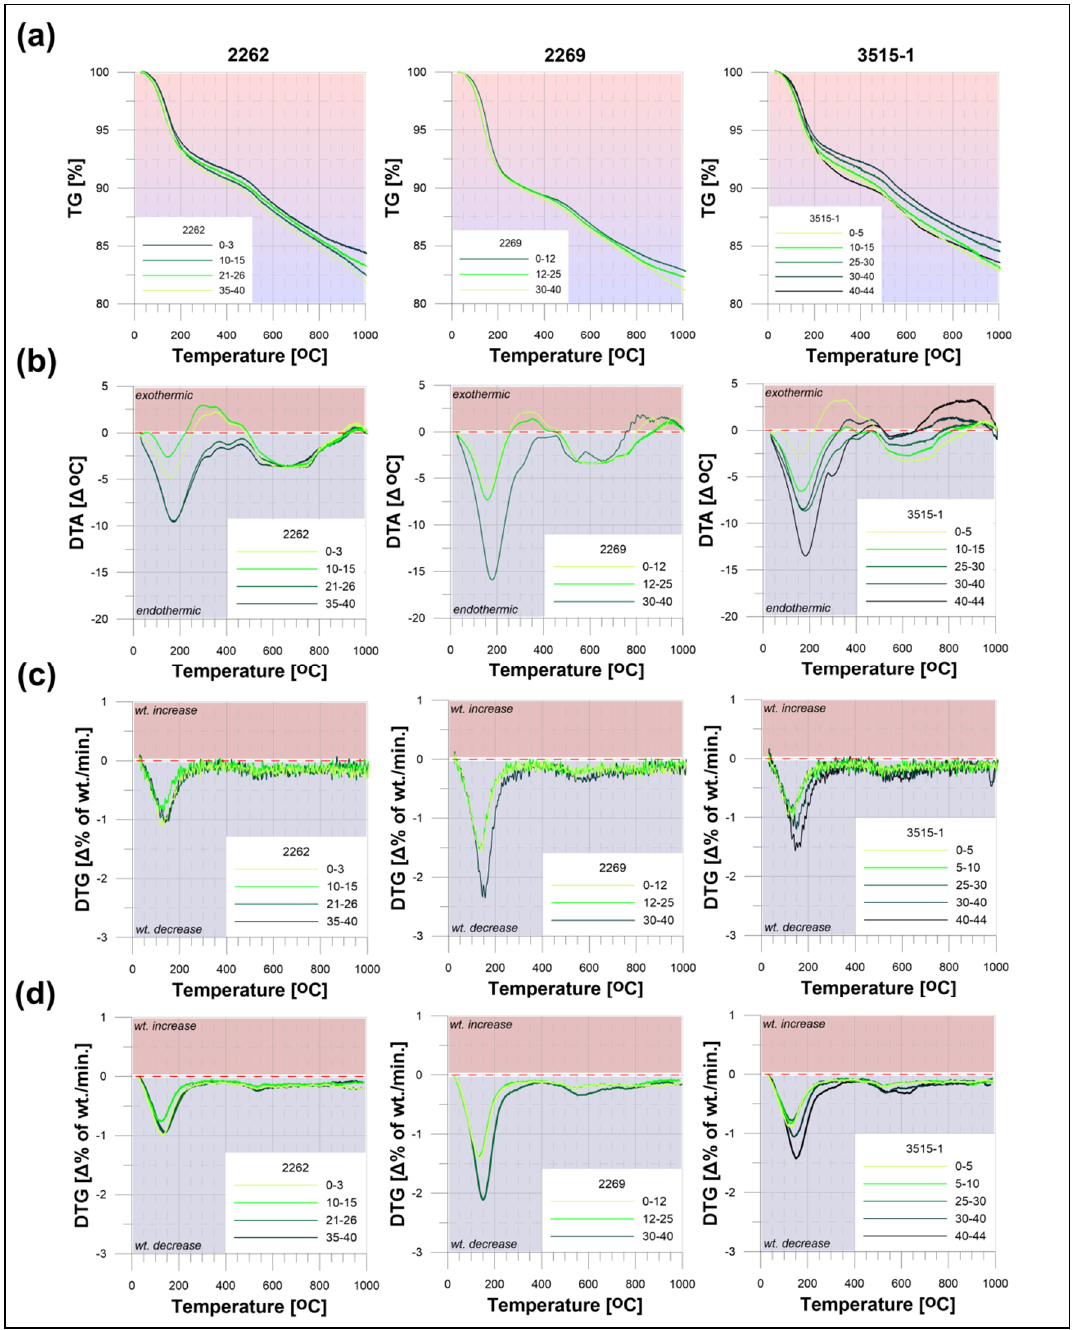
Figure 7. Thermoanalytical curves of pelagic sediments from the CCFZ, IOM claim area. The last row represents smoothed DTG data: ( a ) the thermogravimetry (TG) curves showing sample weight change; ( b ) DTA curves indicating differences between temperatures of sample and reference material (Al 2 O 3 ); ( c ) DTG curves showing rate of weight variations over time; ( d ) smoothed DTG curves (removed short-scale oscillations of weight).